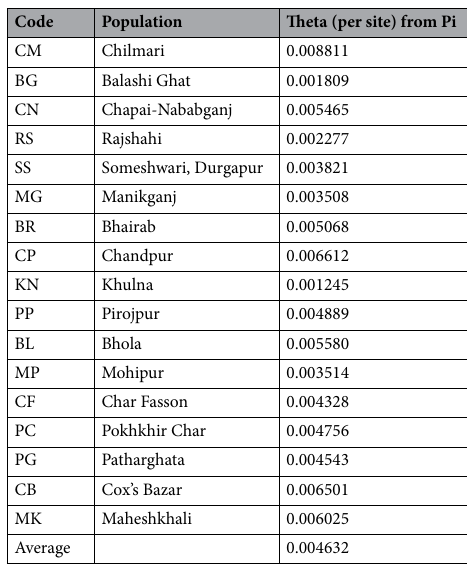
Table 3. Nucleotide diversity (Pi) of each population.